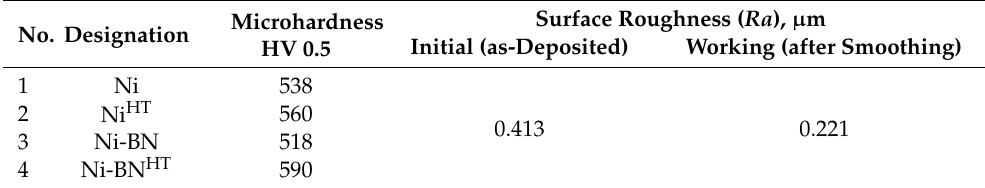
Table 3. Microhardness and surface roughness of the tested samples.